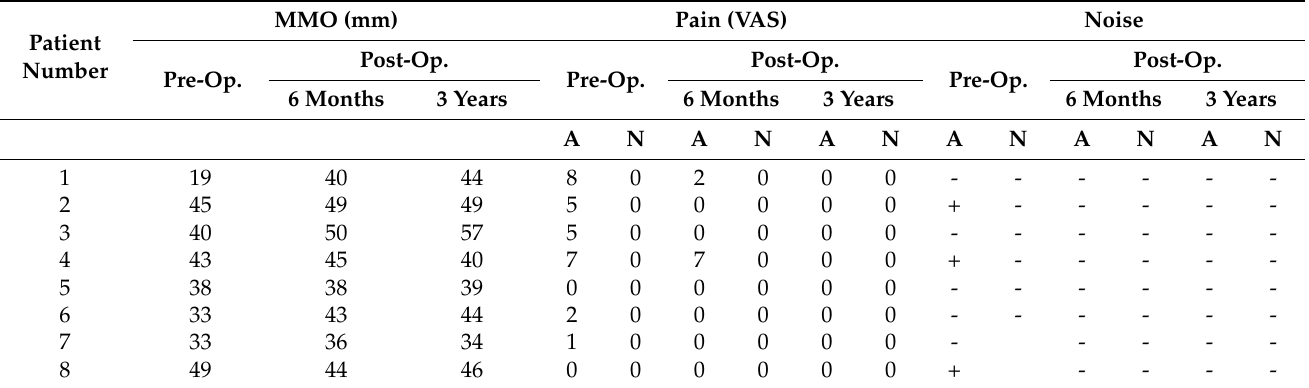
A = alloplastic side of TMJ; N = natural side of TMJ. The consistent tendencies of average MMO change and VAS score change are shown in Figure 3. The average MMO was 37.5 mm pre-operatively, and the last average MMO was 44.1 mm post-operatively. The average lateral excursion movement of the mandible was 1.3 mm to operated side and 7 mm to the natural joint side. The alterations of pain VAS scores during various follow-up visits were consistently decreased to 0 from 3.5. Be- tween one month and three months after surgery, the range of mouth opening was in- creased. The greatest decrease in pain score was observed within one week after surgery.